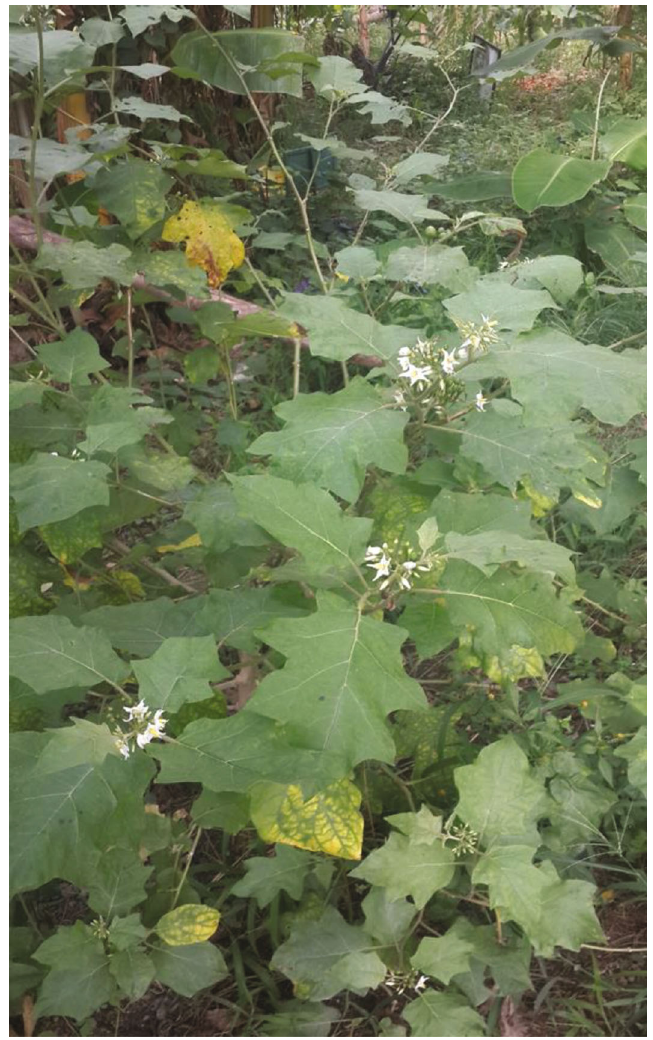
Figure 1: A matured fl owering Solanum torvum plant. Photo credit: Emmanuel Kwadwo